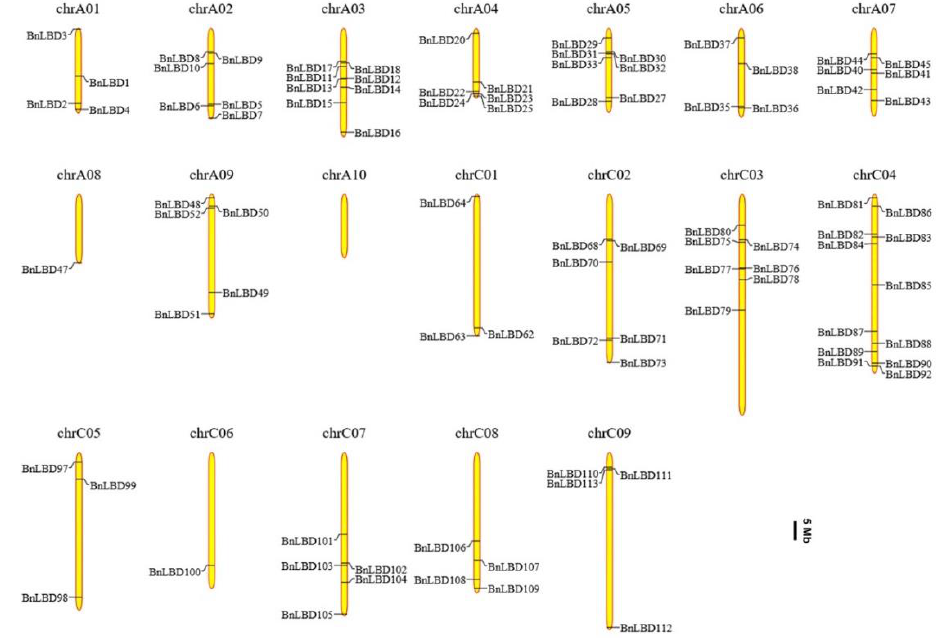
Figure 5. The distribution of BnLBD genes on the B. napus chromosomes. A total of 92 BnLBD genes are mapped to the 19 chromosomes, and the unmapped 34 BnLBDs are unassembled scaffolds. The chromosomal position of each BnLBD gene was mapped to the B. napus genome. The chromosome number is indicated at the top of each chromosome. The scale is in megabases (Mb).